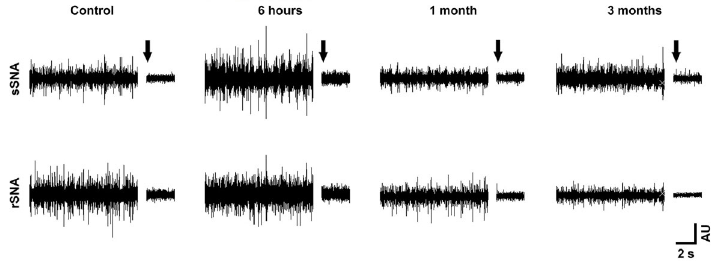
Figure 1. Diagram representing the basal renal/splanchnic sympathetic nerve activity in control rats and in rats 6 h, 1 month, and 3 months after sepsis. Sepsis surviving rats exhibited a lower level of sympathetic vasomotor activity. The arrow indicates the background noise threshold triggered by intravenous hexamethonium. rSNA: renal sympathetic nerve activity; sSNA: splanchnic sympathetic nerve activity.